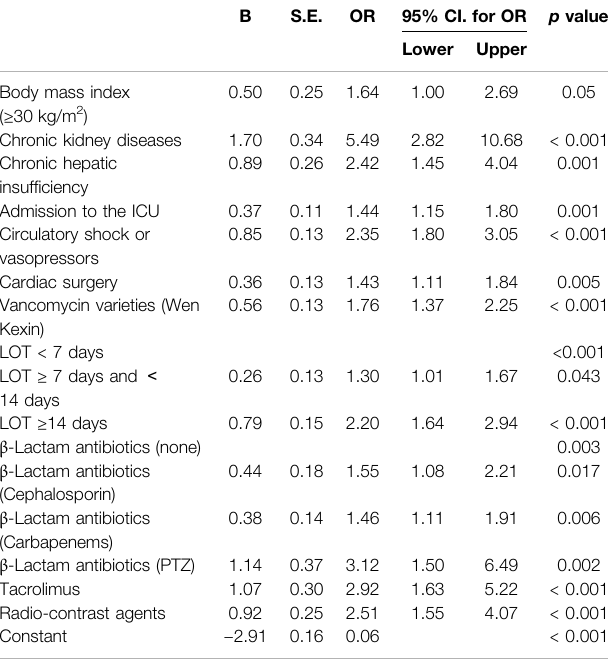
TABLE 3 | Multivariable logistic regression of factors for development of VA-AKI.